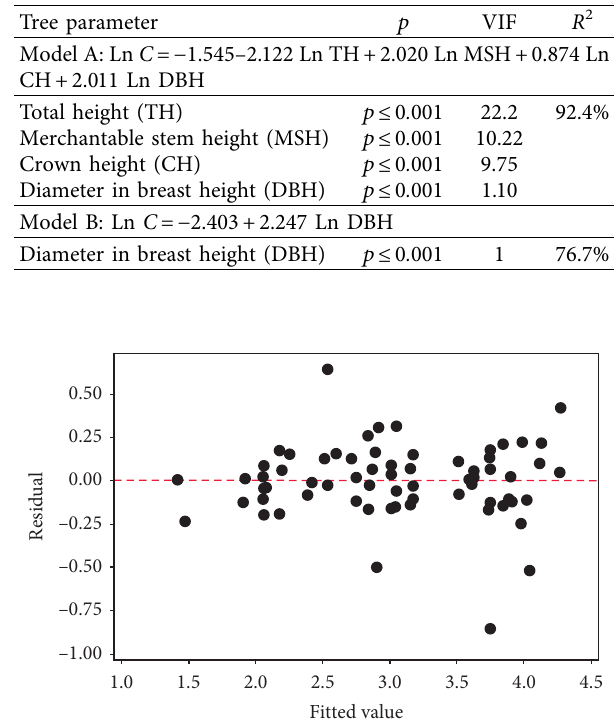
Figure 1: The residual distribution diagram for the best fitted model of Rhizophora mucronata .